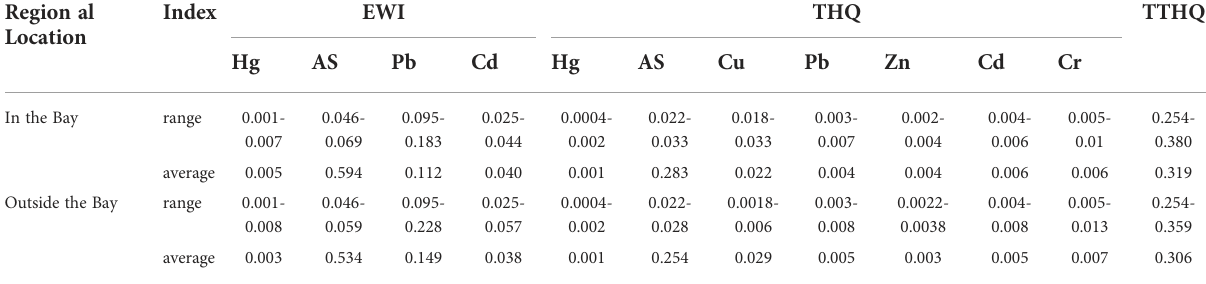
TABLE 5 Marine hazard quotient of Daya Bay.